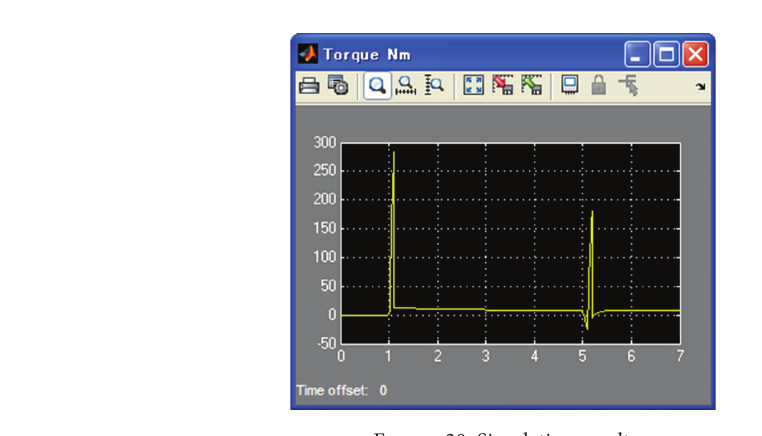
Figure 19: Generated Simulink model.